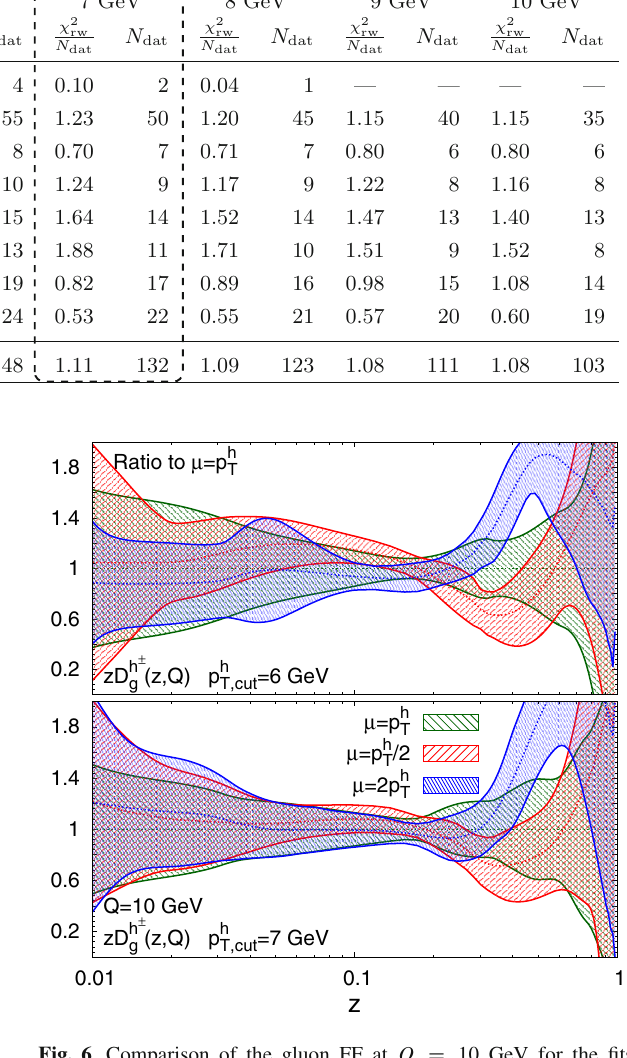
/ 2 for , 2 p h or p h T T T = 7 GeV (lower plot), T , cut